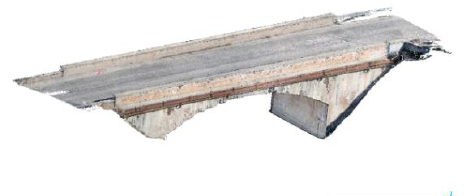
Figure 5. Photogrammetric 3D model of the Cortemaggiore bridge (Piacenza,